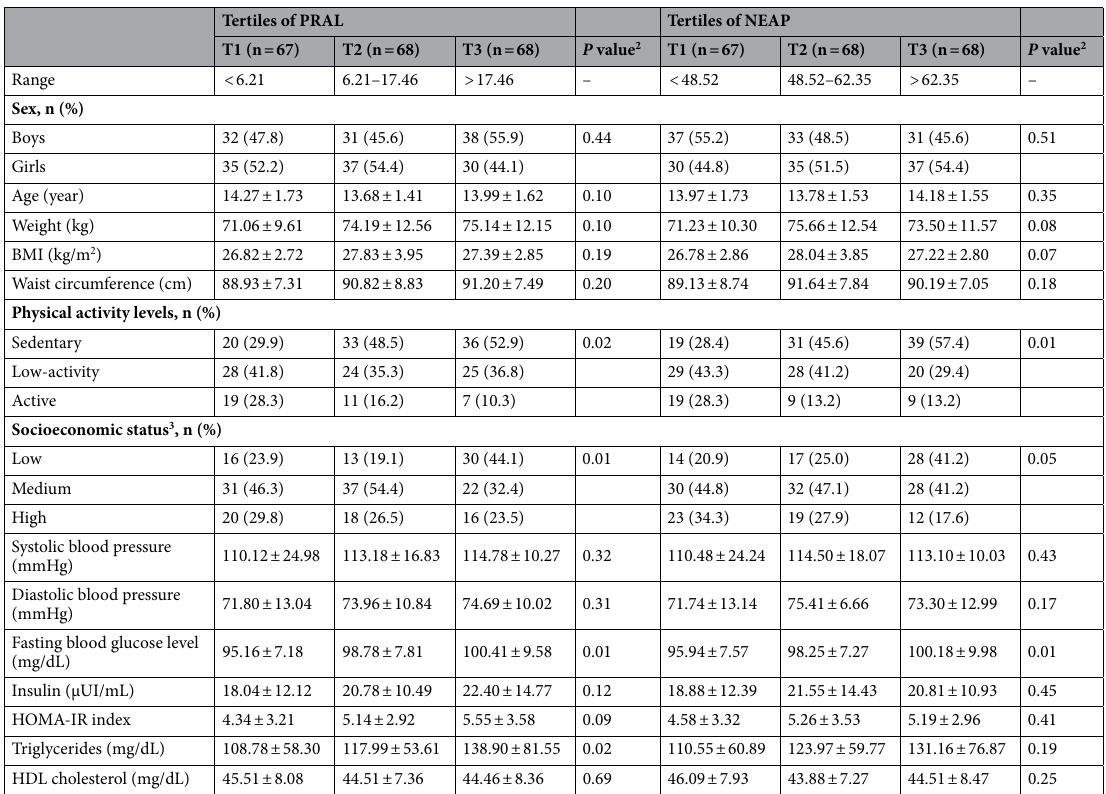
Table 1. General characteristics and cardiometabolic factors of study participants across tertiles of PRAL and NEAP 1 . 1 Values are Mean ± SD; unless indicated. Abbreviations: NEAP: net endogenous acid production; PRAL: potential renal acid load; BMI: Body Mass Index; HOMA-IR: Homeostasis Model Assessment Insulin Resistance; HDL-c: high-density lipoprotein cholesterol; 2 P value for one-way analysis of variance (ANOVA) and χ 2 test for quantitative and categorical variables, respectively. 3 Socioeconomic status (SES) score was evaluated based on parental education level, parental job, number of family members, having car in the family, having computer/laptop, having personal room and having travel by using demographic